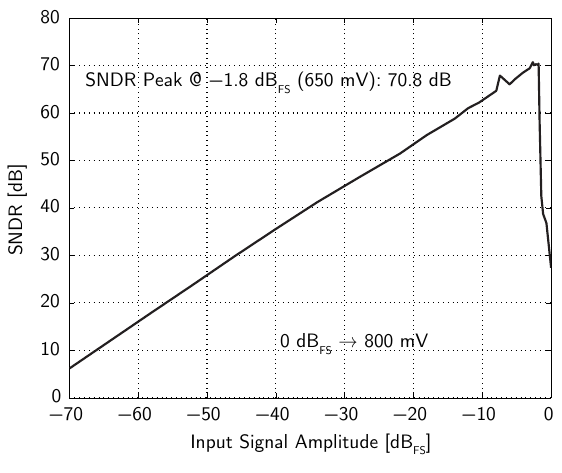
Figure 14. Measured SNDR as a function of the input signal amplitude (example 2).